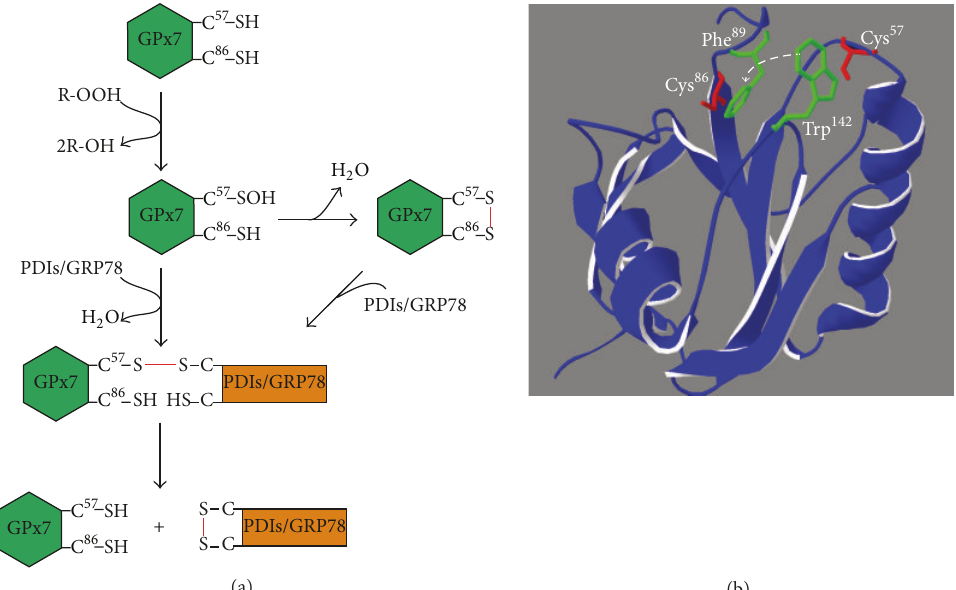
Figure 4: Suggested reaction mechanisms of GPx7. (a) Following peroxide-mediated oxidation of the active site Cys (C 57 ), sulfenylated C 57 is either directly subjected to nucleophilic attack by a (deprotonated) Cys in the reducing substrate (PDIs/GRP78) or attacked by (deprotonated) Cys 86 , which results in formation of an intramolecular disulfide bond. In a second step, this intramolecular disulfide is attacked by a Cys in the reducing substrate. Both pathways converge in the formation of an intermolecular disulfide-bonded intermediate between GPx7 and the reducing substrate prior to the completion of the reaction cycle, which gives rise to regenerated, reduced GPx7 and oxidized PDIs/GRP78. (b) Hypothesized conformational change prior to formation of a Cys 57 –Cys 86 disulfide bond in GPx7 is depicted on the structure of reduced GPx7 (PDB ID 2KIJ). Active site rearrangement upon oxidation of Cys 57 might involve a stacking interaction between the conserved aromatic side chains of Phe 89 and Trp 142 (green), which would move away Trp 142 from Cys 57 (dashed white